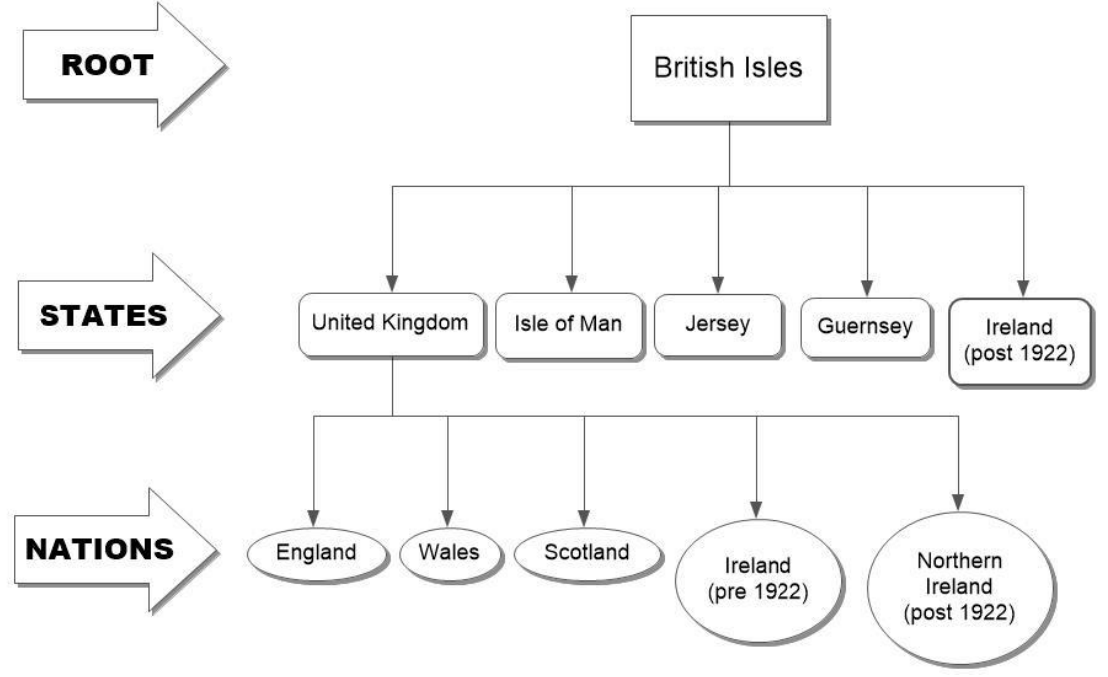
Figure 4. Original Incarnation of AUO Structure, 2003 – 2008.